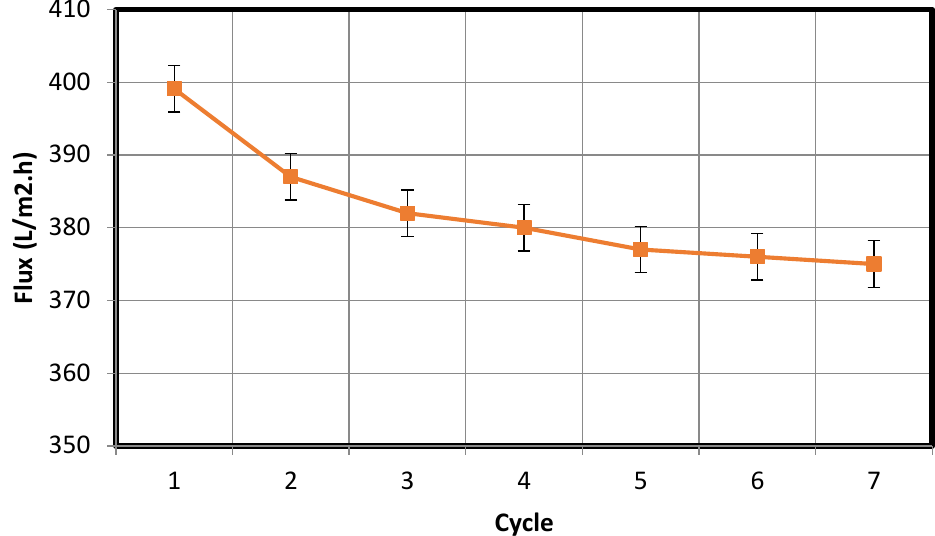
Figure 11. The water flux of seven experimental cycles filtration for oil separation by fabricated membrane.